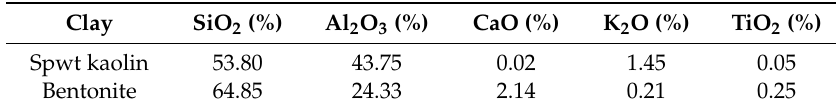
Table 1. Chemical composition of clays.